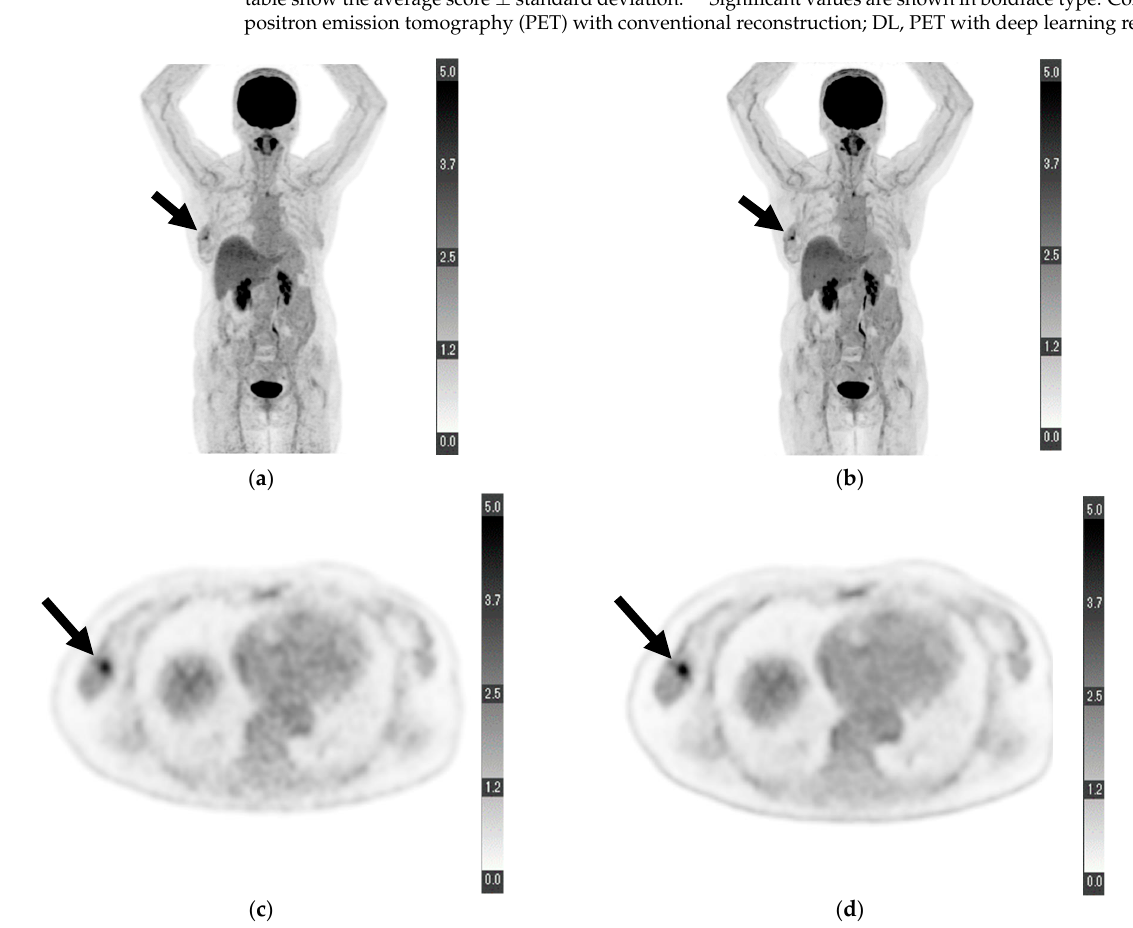
Figure 1. Maximum ‐ intensity projection of ( a ) conventional positron emission tomography (PET) reconstruction and ( b ) deep learning (DL) PET restoration of a woman in her 60 s with invasive ductal carcinoma in the right breast (arrows): invasive diameter, 15 mm; nuclear grade, 2; lymphatic invasion, negative; vascular invasion, negative; estrogen receptor, positive; progesterone receptor, positive; HER2 receptor, positive; Ki ‐ 67 staining, 25.5%; and nodal stage, 0. Axial view of a tumor cross ‐ section for the same woman using ( c ) cPET reconstruction and ( d ) DL ‐ PET restoration. Images were scored on a five ‐ point scale from 1 = extremely poor to 5 = excellent. The scores of reader 1 for “depiction of the primary lesion”, “noise”, “clarity of mammary gland”, and “overall image quality” were 4, 5, 5, and 5 for cPET and 5, 5, 5, and 5 for DL ‐ PET, respectively; the scores of reader 2 were 3, 4, 4, and 4 for cPET and 5, 5, 5, and 5 for DL ‐ PET, respectively.